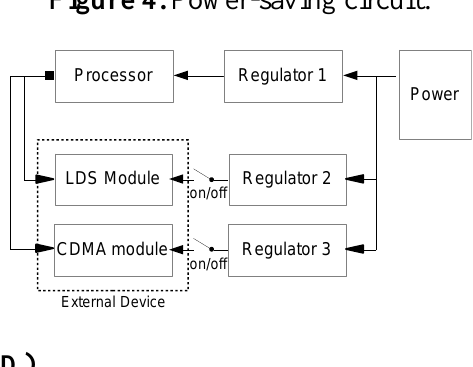
Figure 4. Power-saving